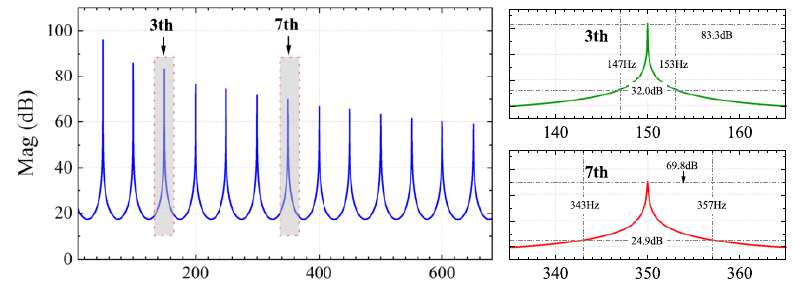
Figure 2. CRC magnitude response: 10 Hz–680 Hz, 3rd harmonic, and 7th